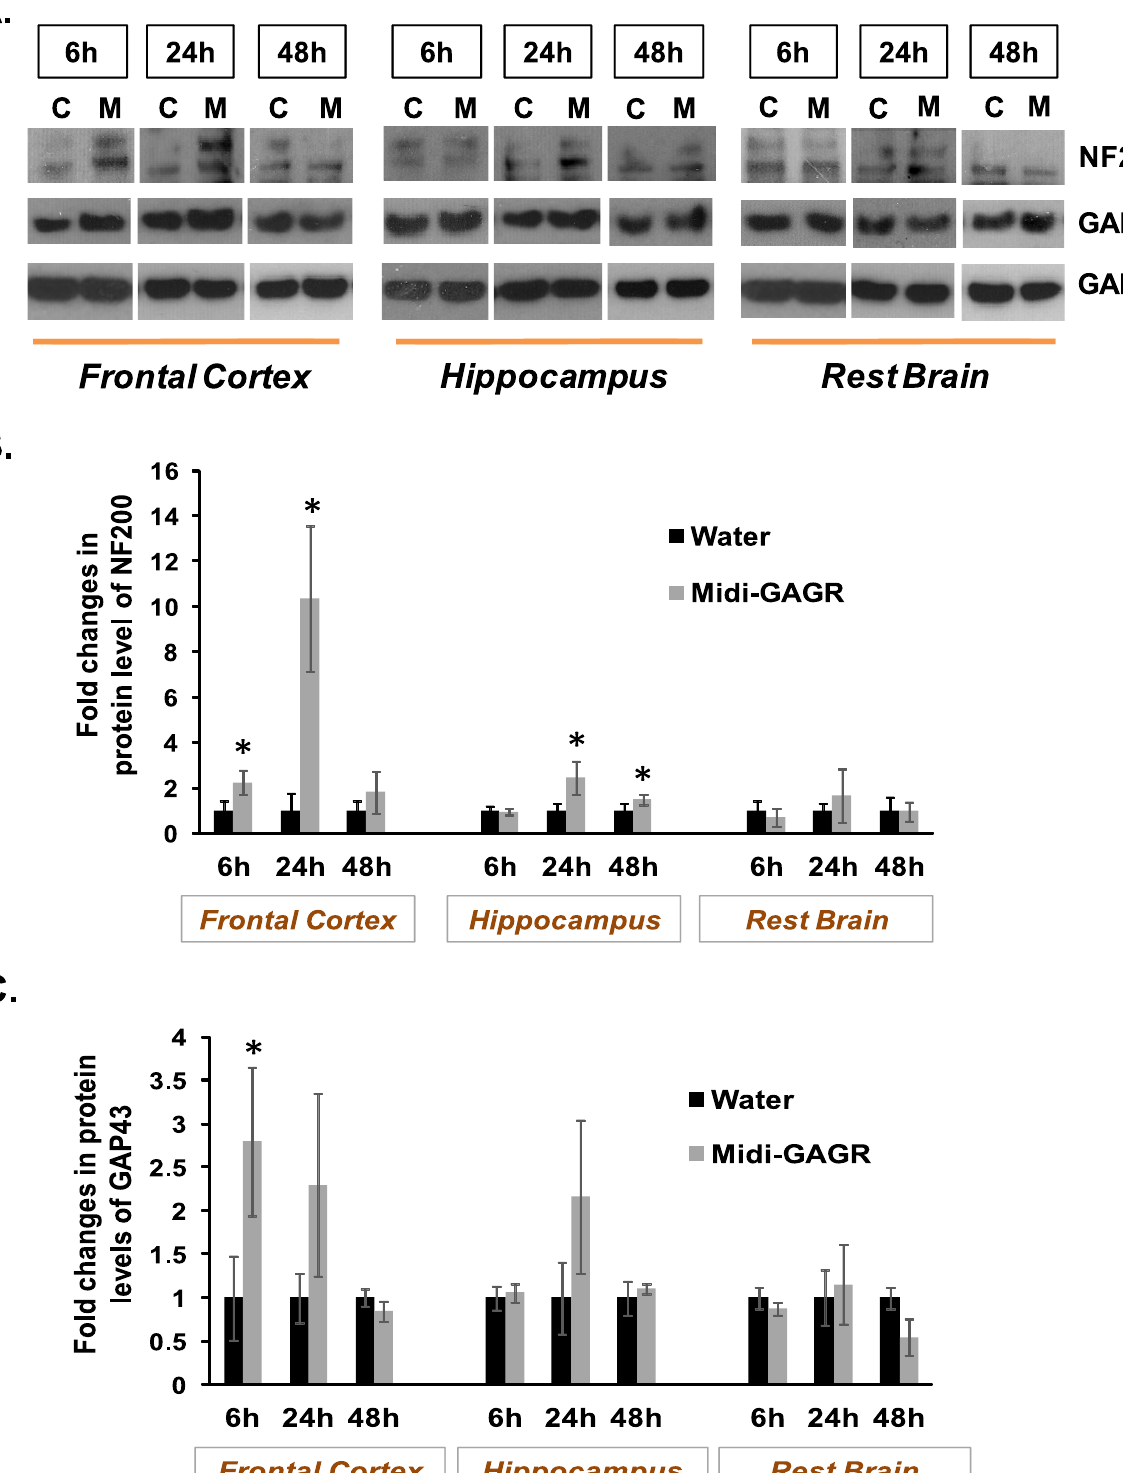
Fig 9. Intranasally administered midi-GAGR increases the expression of NF200 and GAP-43 in the brains of live rats. SD rats were intranasally administered with either vehicle or midi-GAGR and processed to obtain brains at 6h, 24h or 48h after the administration. Brains were dissected to the frontal cortex, hippocampus, and rest of the brain. (A) Brain tissue lysates were processed for immunoblotting using the antibody to NF200 (upper panel), GAP-43